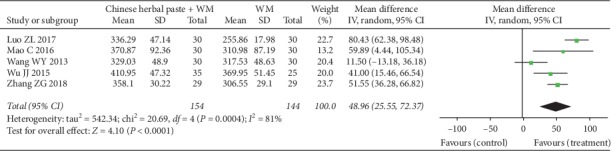
Forest plot of 6MWD.